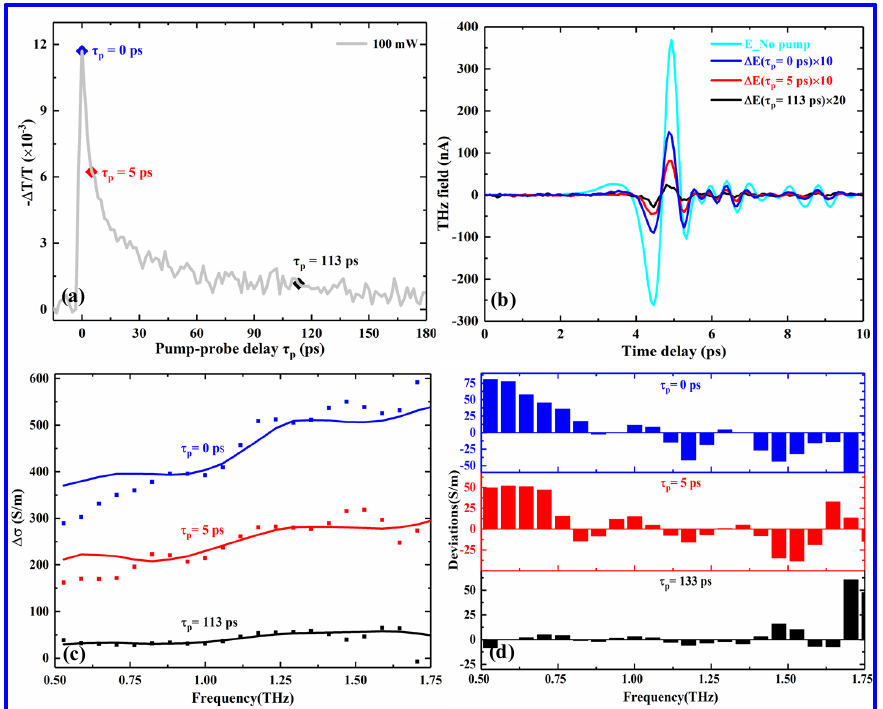
Figure 7. Changes in the THz transmission field, and photoinduced conductivity of the (PEA) 2 (MA) 2 Pb 3 I 10 film at a pump power of 100 mW: ( a ) THz transmission change at different pump − probe delay times, ( b ) THz field change at τ p = 0, 5 and 113.3 ps, ( c ) THz photoinduced conductivity changes at τ p = 0, 5 and 113.3 ps, and ( d ) deviations between the extracted and fitted photoinduced conductivities.